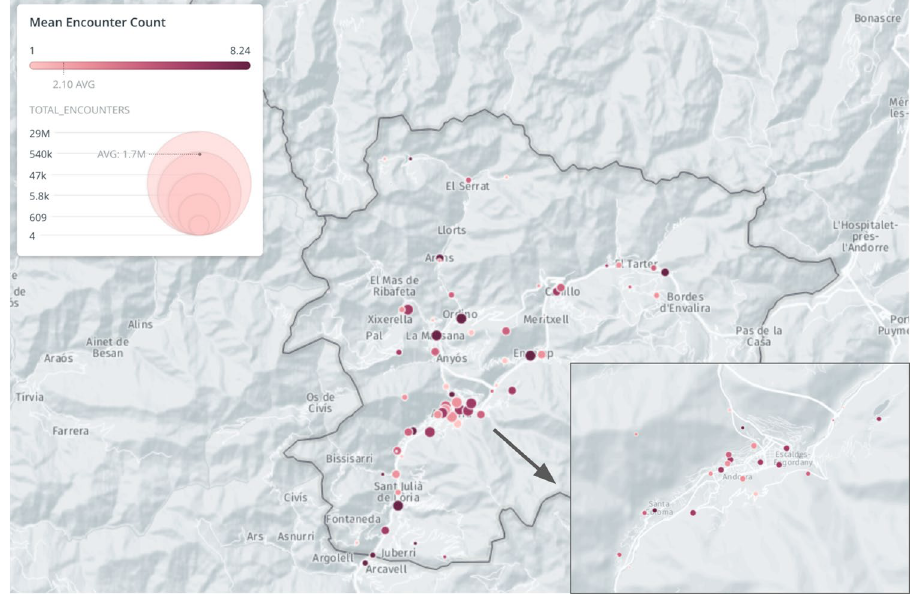
Figure 3. Spatial distributions of encounters. Each node on the map corresponds to one cell tower. The size of the node is proportional to the total number of encounters. Darker red corresponds to more encounters for each encounter pair. This figure is generated using CartoDB (https:// carto. com).